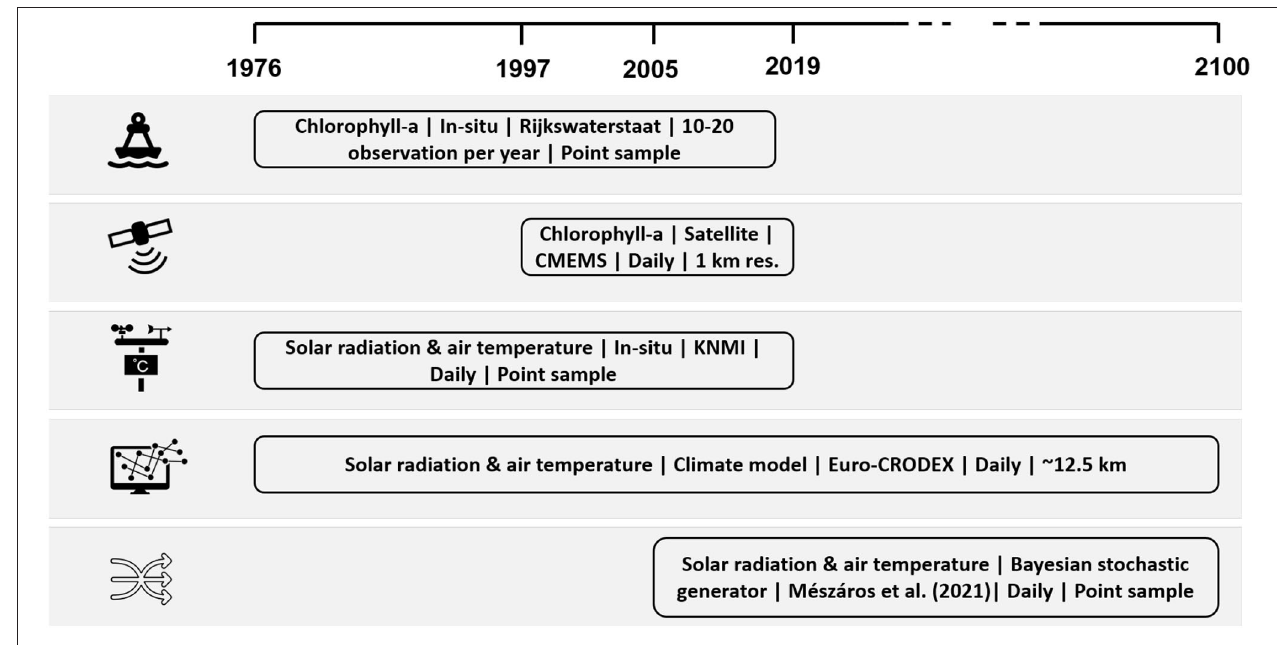
FIGURE 3 | Overview of data sources. The description includes variable name, data type, data source, data frequency, and spatial